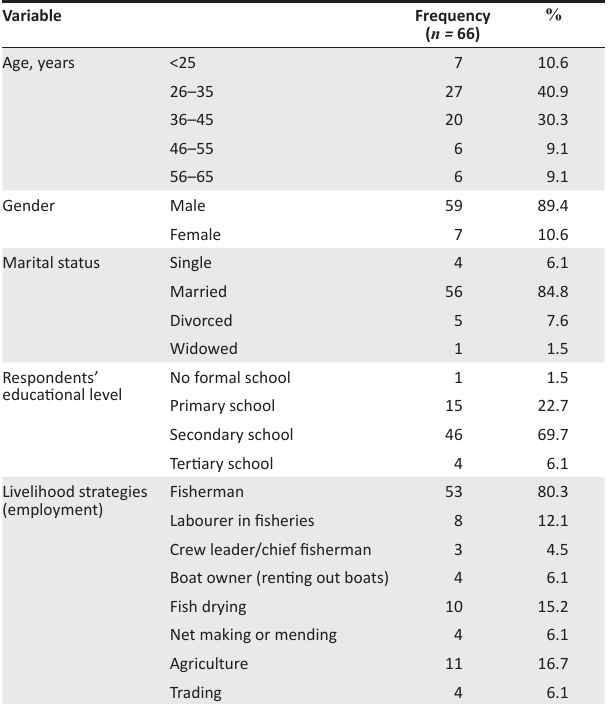
TABLE 1: Demographic characteristics of respondents. Variable